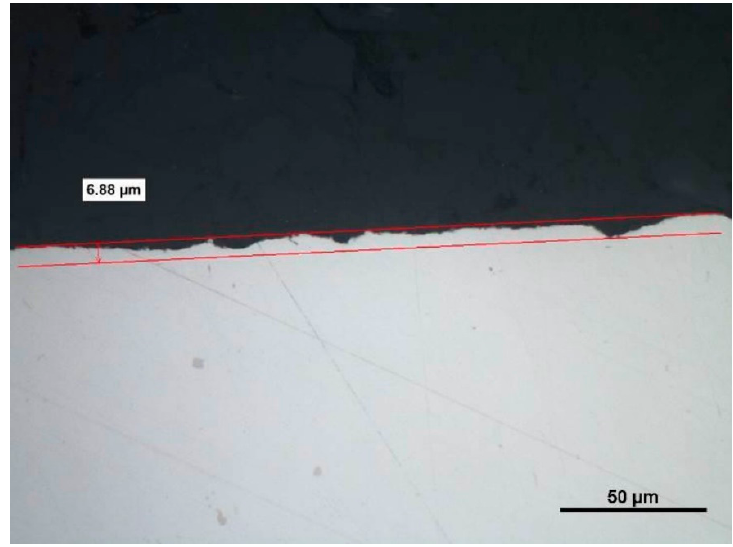
Figure 28. A view of a microsection after longitudinal turning without cooling and before etching. Analysis of the microstructure proved that during machining without coolant, the generated heat penetrated the material under machining, changing the microstructure in its top layer (Figure 29). Ezugwu et al. [20] observed that the properties of Inconel 718 resulted in the deformation of the cutting edge and the part under machining, which was the reason for generation of heat and plastic deformations. Generated heat usually changes the microstructure of the alloy and causes stresses arising in the top layer. The temperature and deformation, together or separately, can cause cracks and microstructure changes during machining. The influence of heat on the change of microstructure was not observed in machining with the use of coolant (Figure 30). The influence of the cutting insert on deformation of grains was visible. The depth of microstructure changes for the case under consideration was 4.49 µ m; for dry machining, the changes reached over 16 µ m (i.e., almost four times as much).